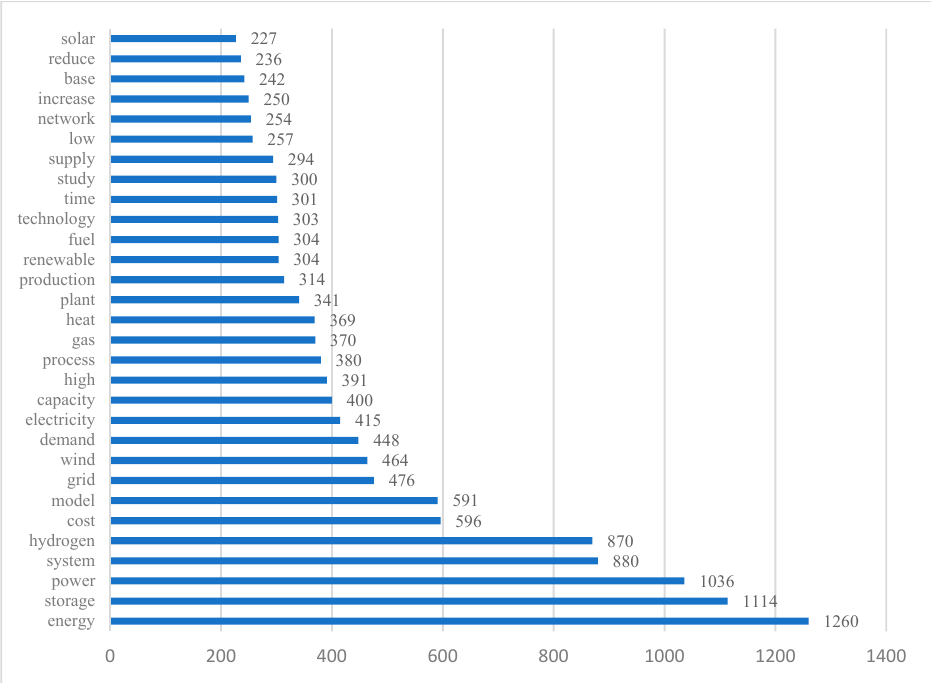
Figure 3. The thirty most common words with their respective frequencies. Source: own elaboration based on an analysis in the IRAMUTEQ software.